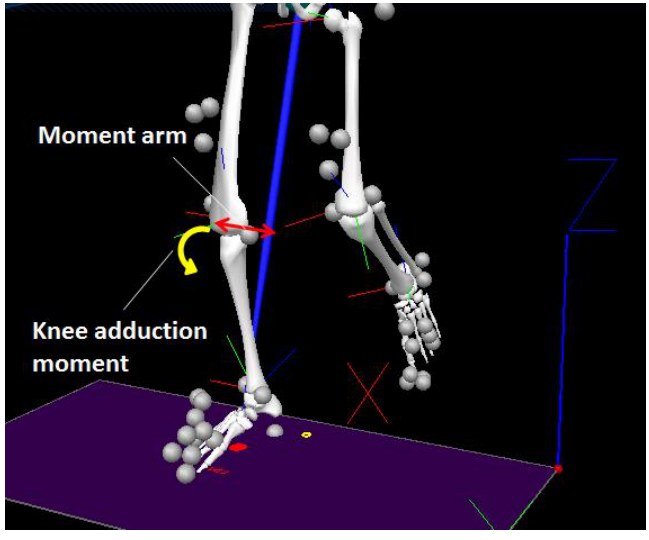
Figure 3. Illustration of marker setup for gait analysis; knee adduction moment due to shank external rotation. external